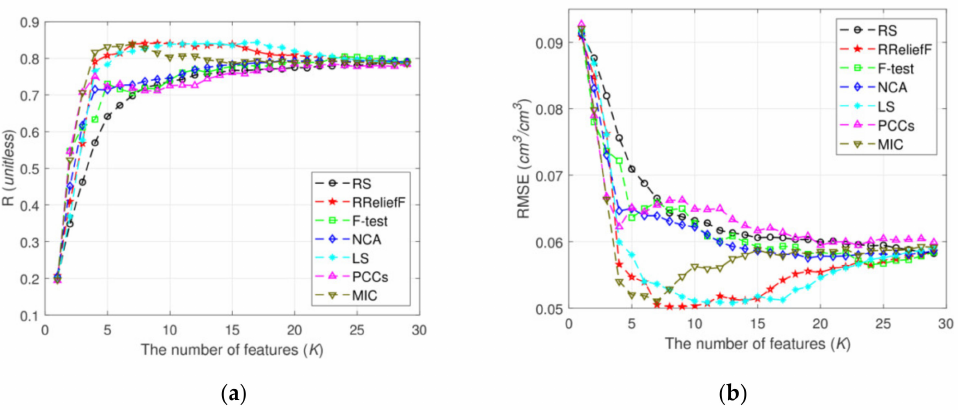
Figure 4. ( a ) R and ( b ) RMSE based on different filter type feature selection methods as a function of the number of features.